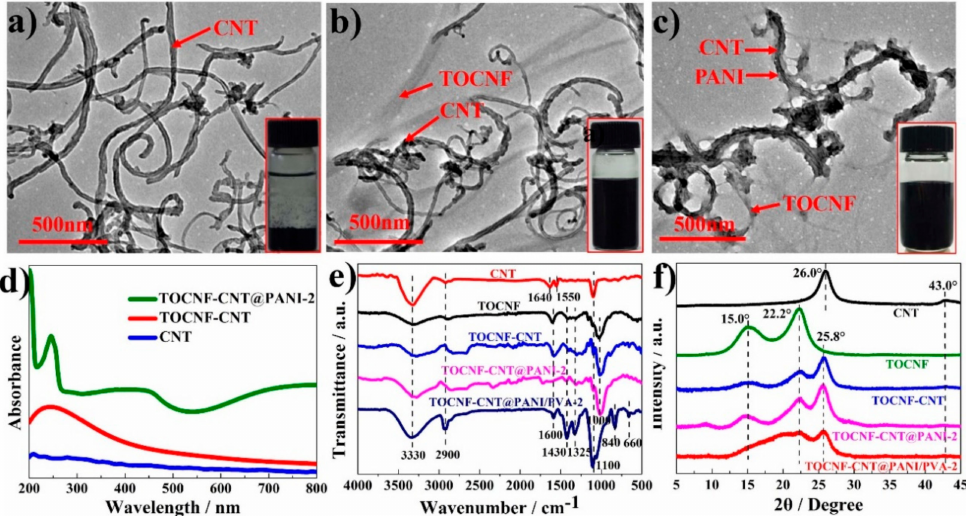
Figure 2. Transmission electron microscope (TEM) images of ( a ) CNTs, ( b ) TOCNF-CNT nanohybrids, ( c ) TOCNF-CNT@PANI nanohybrids, and the inset in each image represents the corresponding dispersion state of each suspension at the concentration of 0.5 wt%; ( d ) Ultraviolet-visible (UV-vis) spectra of neat CNTs, TOCNF-CNT, and TOCNF-CNT@PANI-2 nanohybrids in water. ( e ) Fourier transform infrared (FTIR) spectra and ( f ) X-ray di ff raction (XRD) patterns of TOCNFs, CNTs, TOCNF-CNT, TOCNF-CNT@PANI-2 nanohybrids, and TOCNF-CNT@PANI / PVA-2 composite